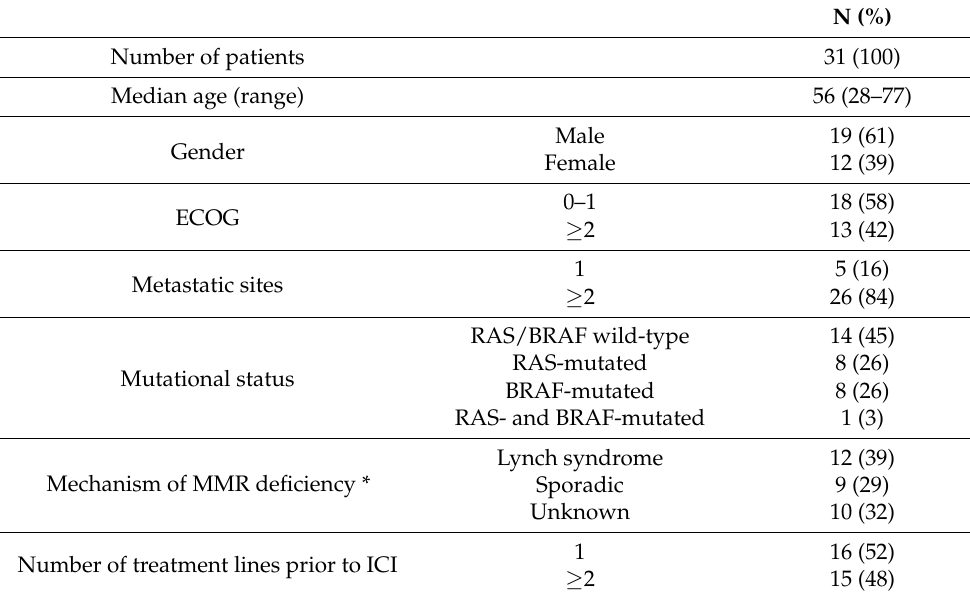
Table 1. Baseline